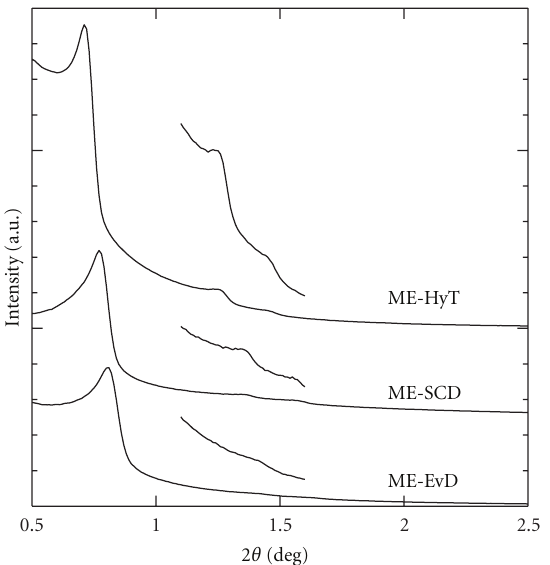
Figure 2: XRD patterns of the ME-EvD, the ME-SCD, and the ME- HyT samples.